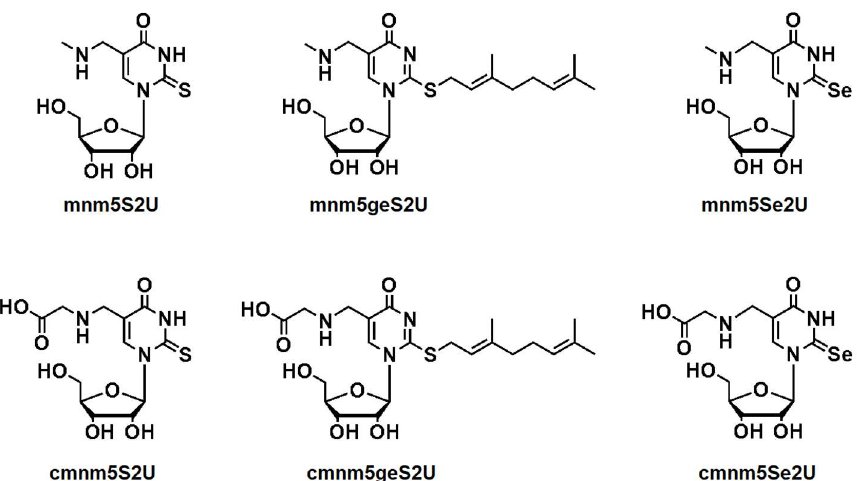
Figure 1. Modified wobble uridines present in bacterial tRNAs specific for lysine and glutamate (5-methylaminomethyl-2-thiouridine (mnm5S2U), 5-methylaminomethyl- S -geranyl-2-thiouridine (mnm5geS2U), and 5-methylaminomethyl-2-selenouridine (mnm5Se2U)) and those present in tRNA specific for glutamine (5-carboxymethylaminomethyl-2-thiouridine (cmnm5S2U), 5-carboxymethylaminomethyl- S -geranyl-2-thiouridine (cmnm5geS2U), and 5-carboxymethylaminomethyl-2-selenouridine (cmnm5Se2U)).